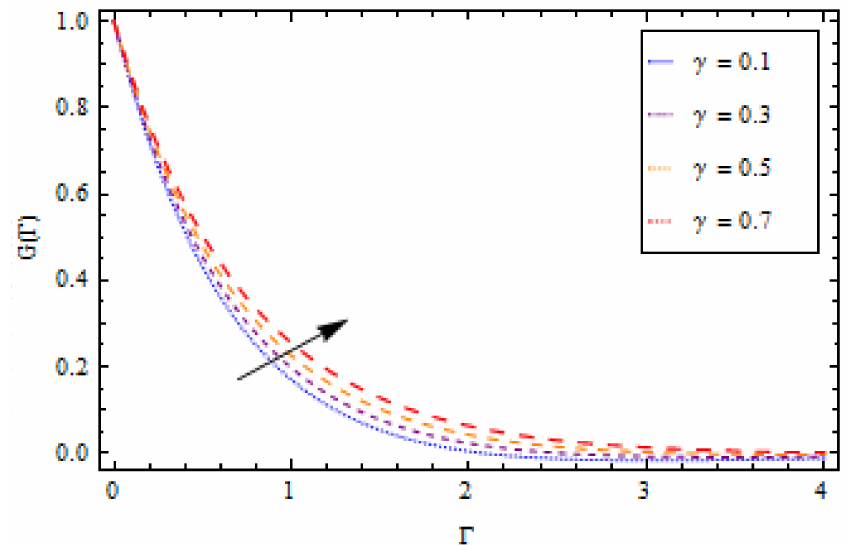
Figure 11. Impact of γ on temperature profile G ( Γ ) , when Pr = 0.5, Rd = 0.5, K = 0.5, κ = 0.5, λ = 0.5, Sin τ = 1.0, A = 0.5.